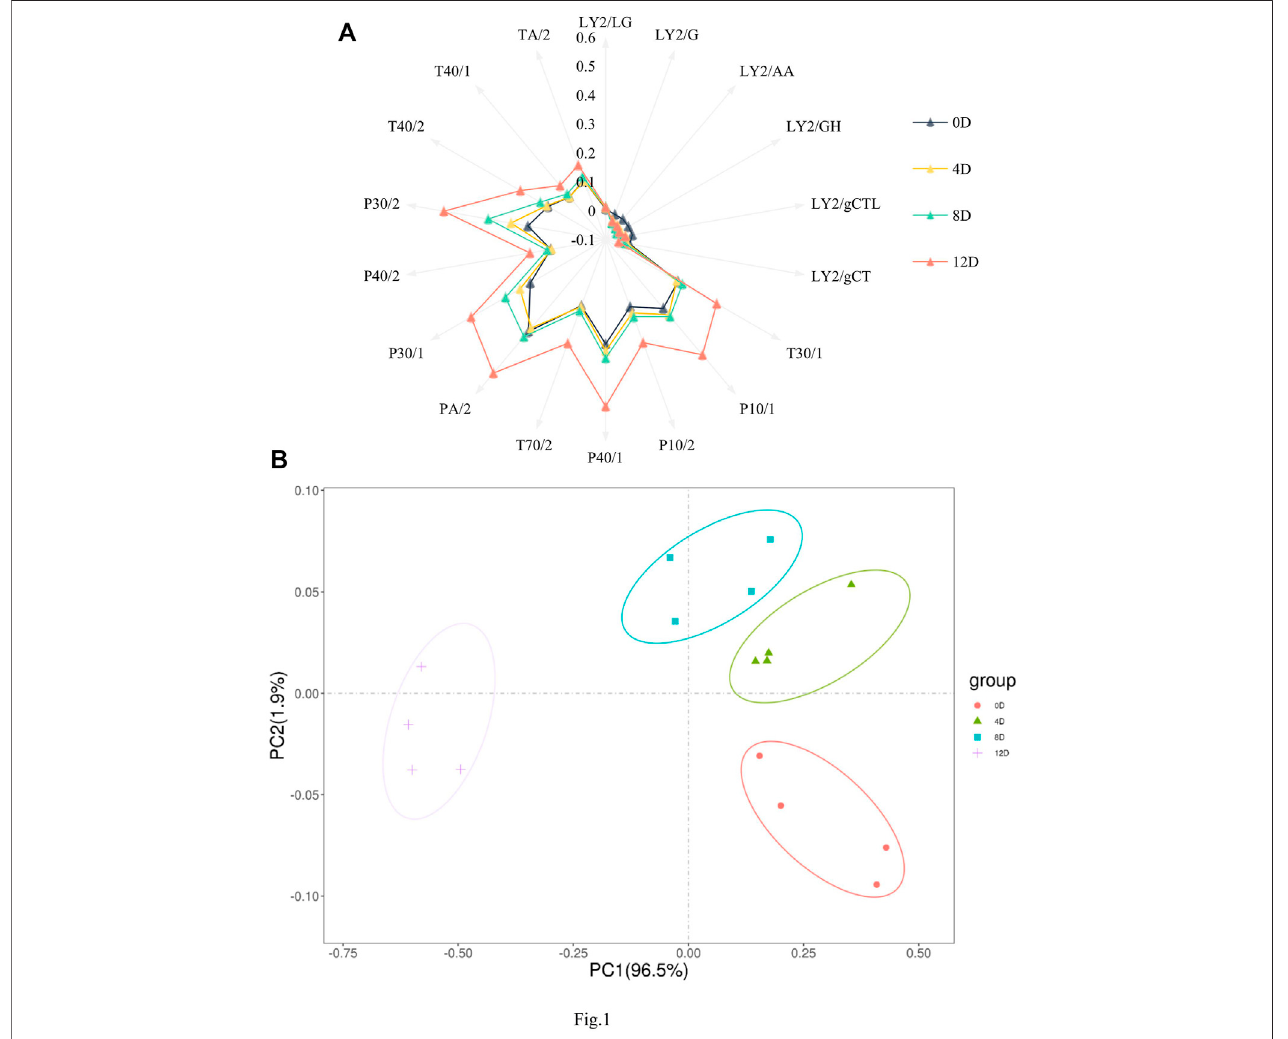
FIGURE 1 | Radar charts. (A) and principal component analysis plot. (B) of the fl avor pro fi les of fermented mandarin fi sh. Values are obtained from four biological replicates.